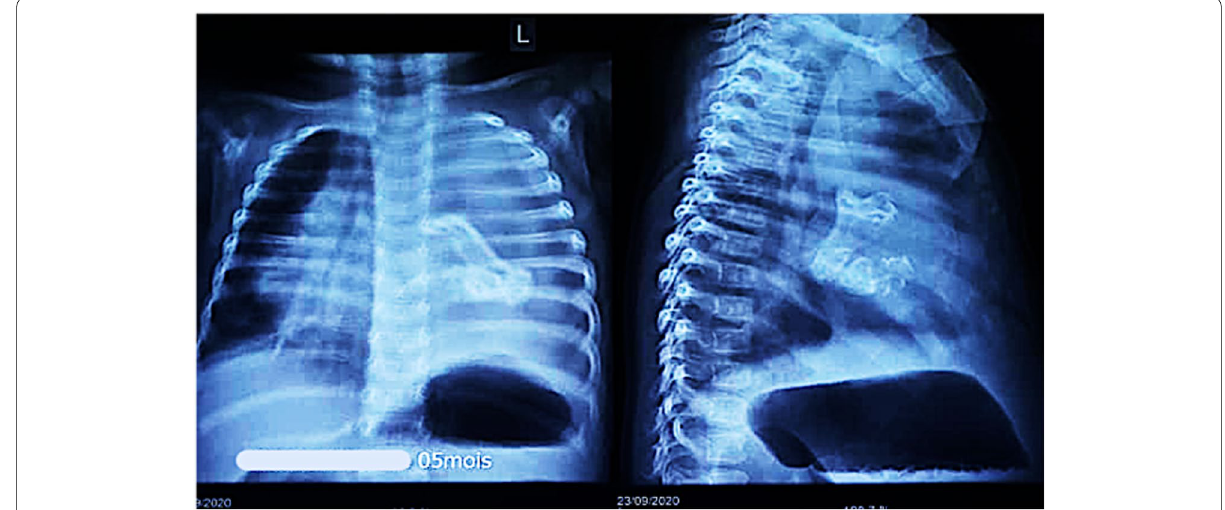
Fig. 1 Persistent opacity of the left hemithorax with axial opacity of skeletal‑looking bone density with rightward deviation of the